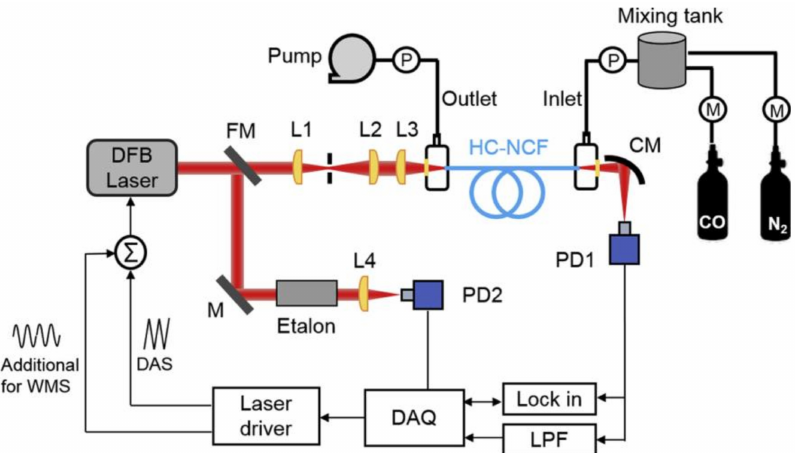
Figure 15. Experimental setup of the tunable diode laser absorption spectroscopy (TDLAS)-based CO sensor using the HC-ARF. FM: flip mirror; L: lens; M: mirror; CM: concave mirror; PD: photodetector; P: pressure gauge; M: mass flow meter; LPF: low-pass filter